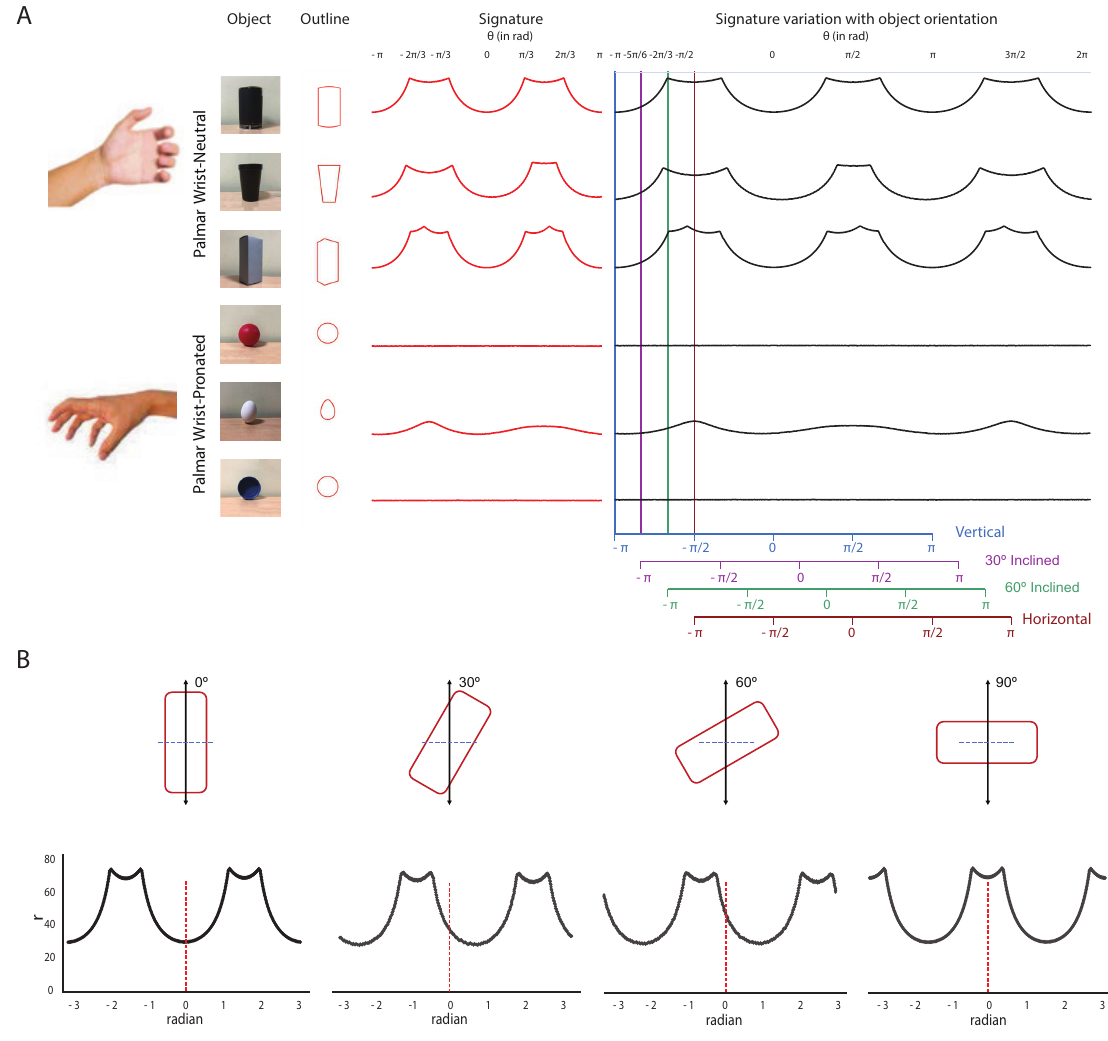
Figure 5. ( A ) Signature of different objects and their variation with orientation and ( B ) An example of the relationship between the boundary signature and the orientation of the